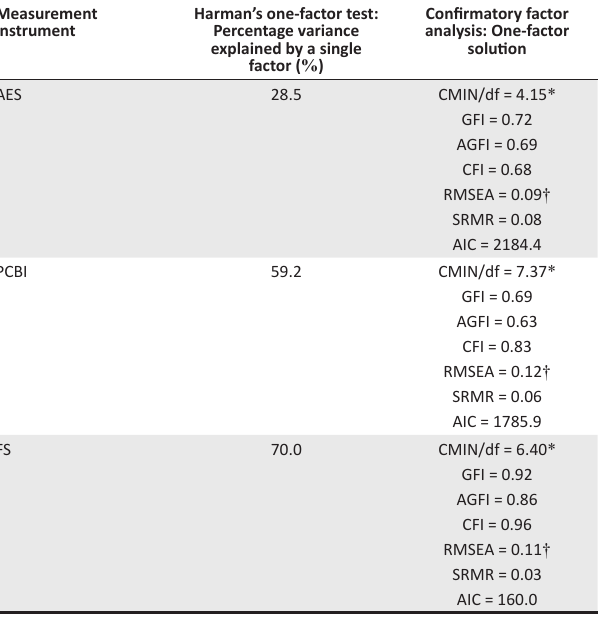
TABLE 1: Test for common method bias: One-factor solutions. Measurement instrument